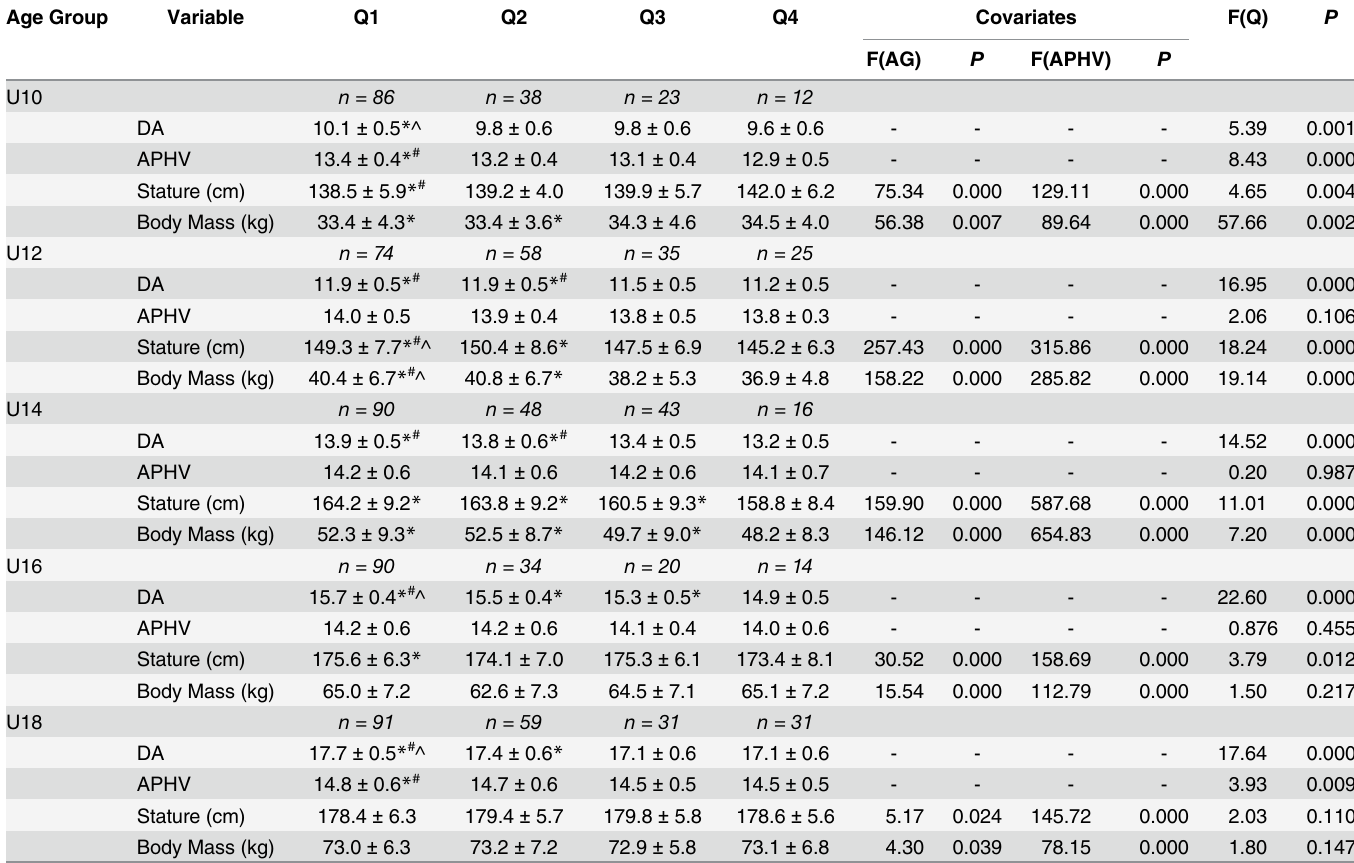
Table 2. Decimal age, maturation, stature and body mass of junior soccer players according to relative age quartile & bi-annual age-groups.